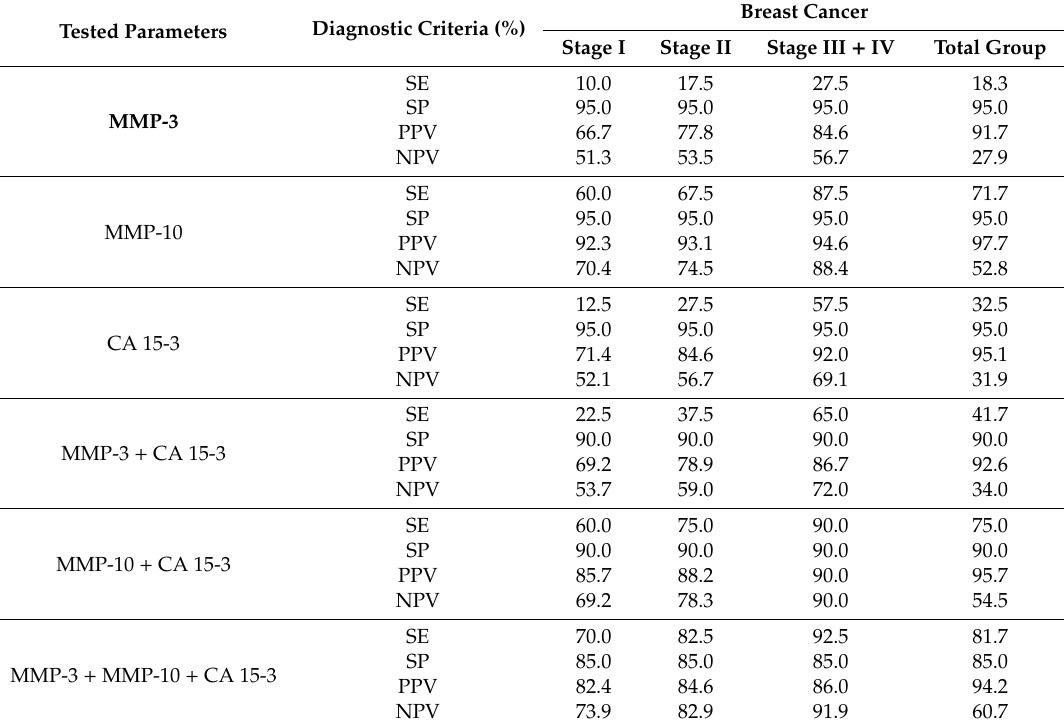
Table 3. The diagnostic criteria of tested parameters in patients with BC. Tested